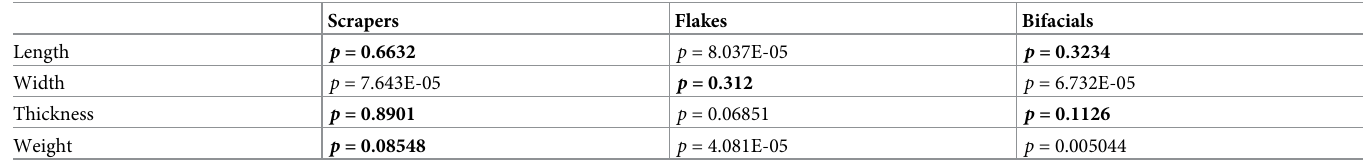
Table 3. Mann-Whitney U tests on length, width, thickness and weigth between Keilmesser and other artefacts’ typologies; in bold, p values > 0.05 attest no statisti- cally significant differences.